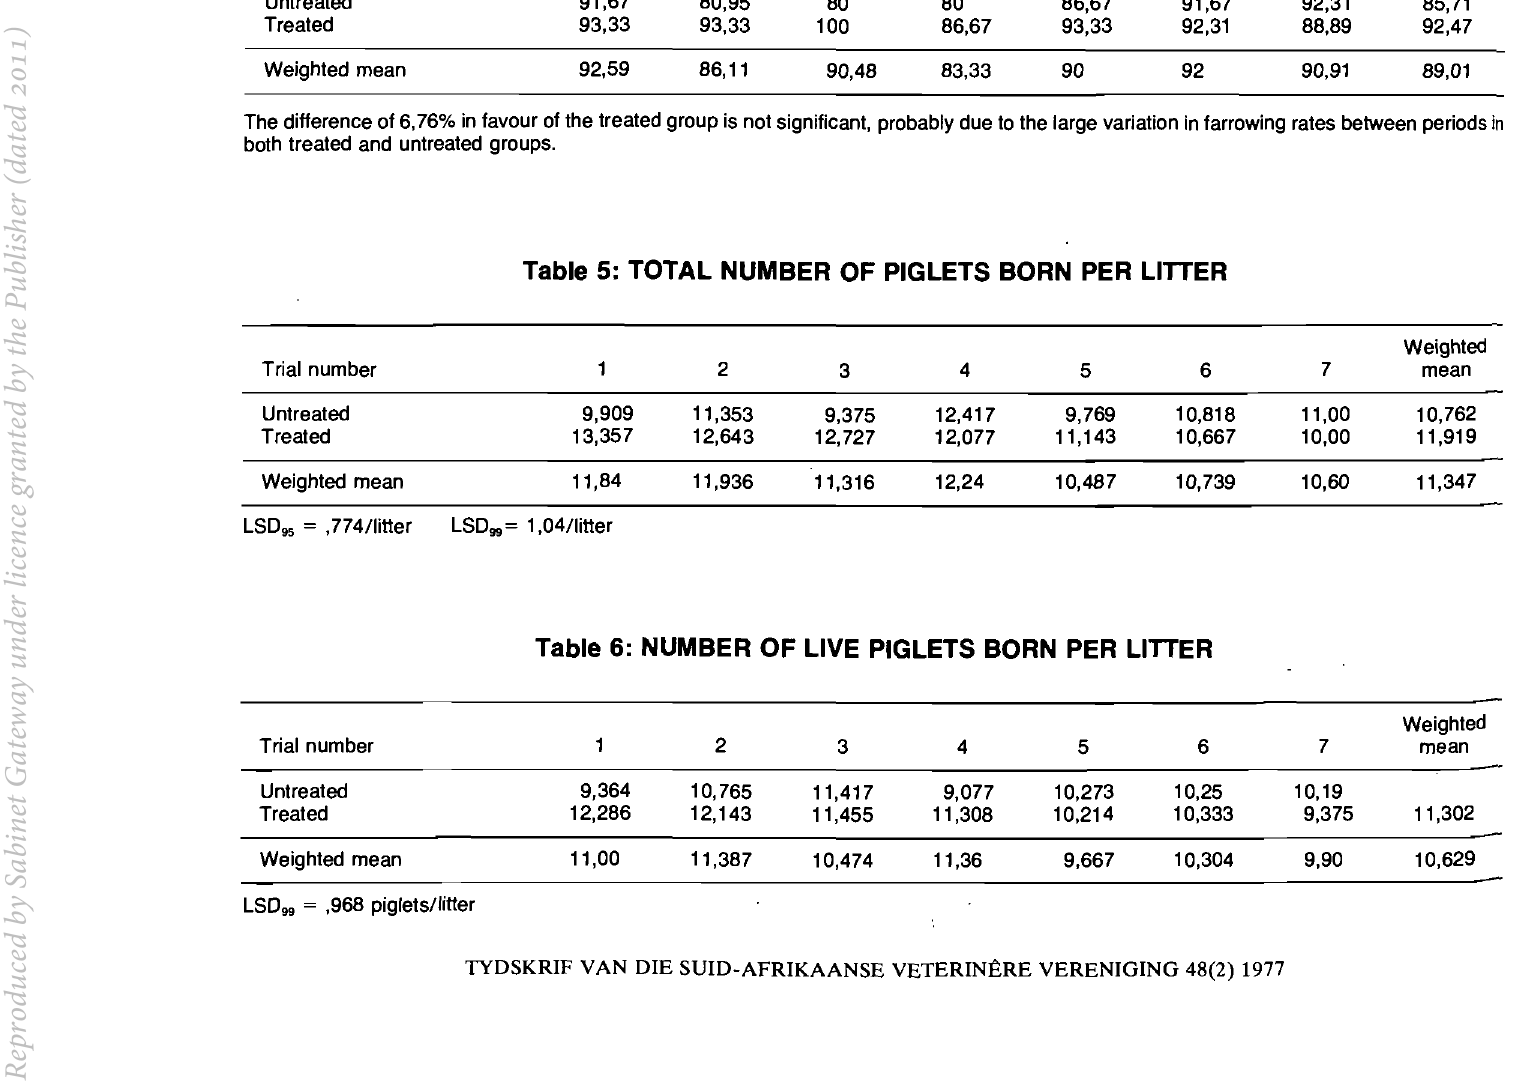
Table 4: FARROWING RATES AS A PERCENTAGE OF SOWS SERVED